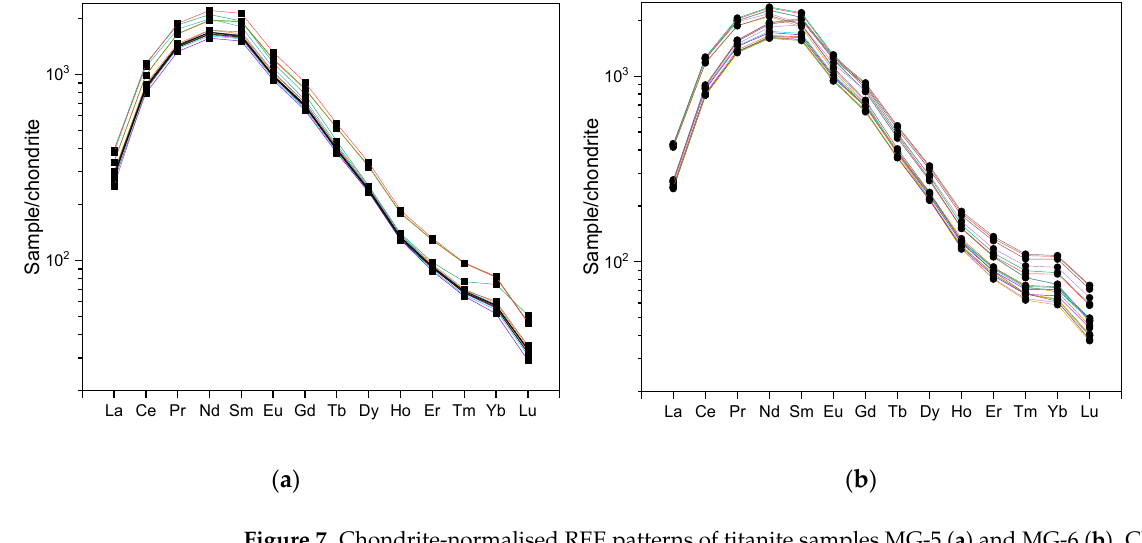
Figure 7. Chondrite-normalised REE patterns of titanite samples MG-5 ( a ) and MG-6 ( b ). Chondrite REE values from McDonough, W.F. and Sun, S.S. (1995) [44]. Lines with different colors represent data of different spots in measurement by LA-ICP-MS.